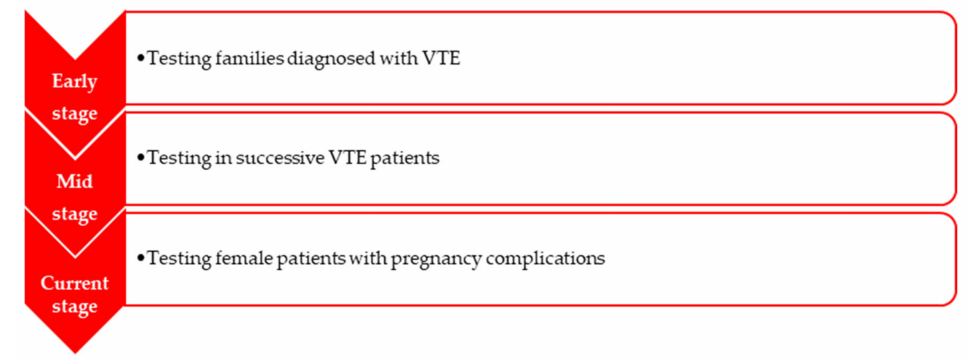
Figure 1. Progression of hereditary thrombophilia testing (information taken from